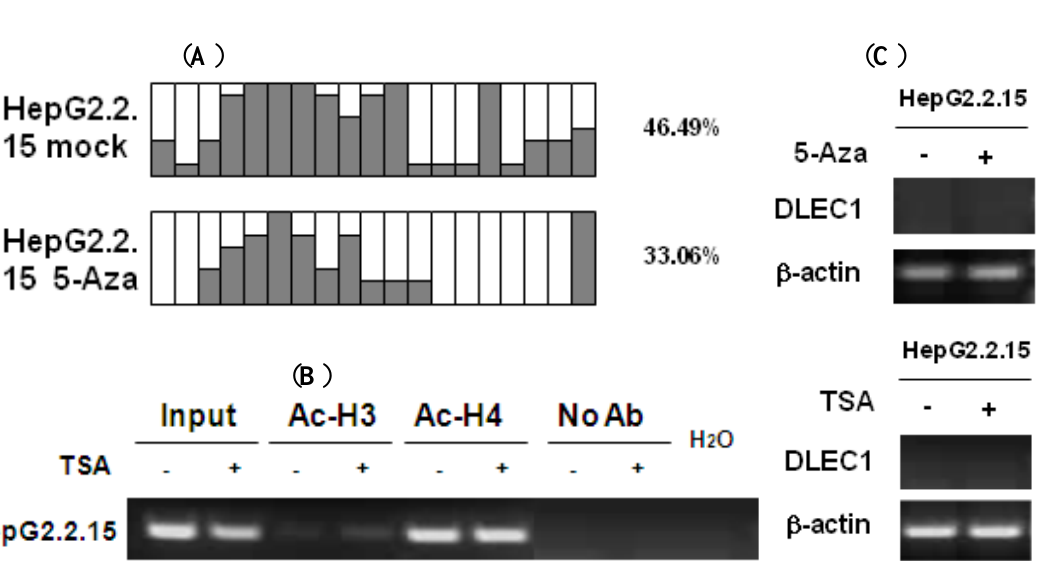
Figure 3. DNA methylation and histone acetylation status of DLEC1 and its expression in HepG2.2.15 cells. (A) Promoter methylation analysis by bisulfite genome sequencing of DLEC1 5’ CpG sites in HepG2.2.15 with or without treatment of 5-Aza-dC. Open area indicates the percentage of unmethylated CpG sites, while dark area indicates percentage of methylated CpG sites. The quantitative result in percentage of methylated CpG sites is listed on the right of the column groups. Three independent experiments were carried out and representative result from one of them was listed here. (B) ChIP analysis of 5’ region of DLEC1 in HepG2.2.15 mock treated or TSA treated. Input indicated 1% of total DNA prior to immunoprecipitation. (C) RT-PCR analysis of DLEC1 expression in HepG2.2.15 treated by either 5-Aza-dC or